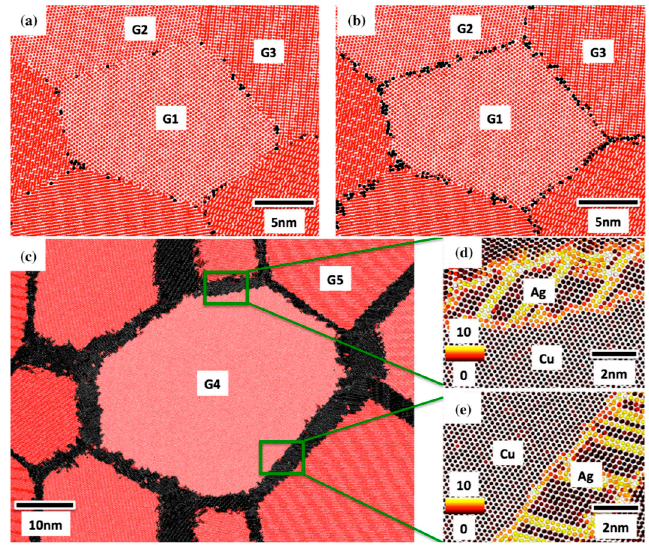
Figure 13. Microstructures of Ag doping Cu grain boundaries; ( a – c ) samples are based on the increases in Ag concentration; ( d , e ) are the Cu/Ag interfaces. For ( a – c ), red denotes Cu and black denotes Ag; for ( d , e ), the perfect FCC structure is marked 0, the light color, while defects are marked 10, the black color. Reproduced with permission from Reference [256]. Copyright 2017, Springer Nature.